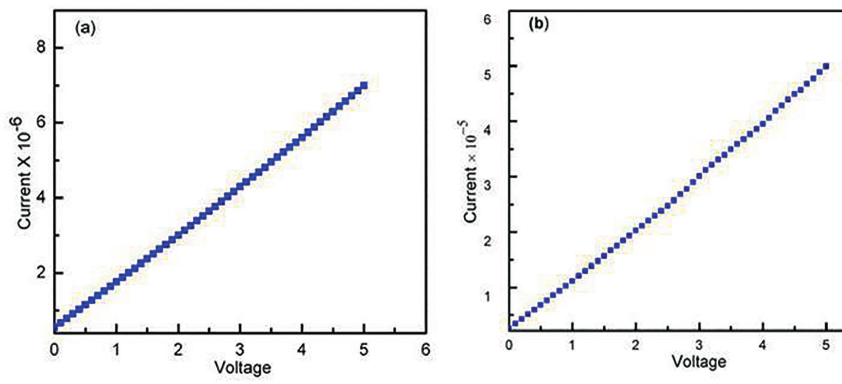
Figure 6: I-V characteristics of (a) PPY (b) nanocomposite.